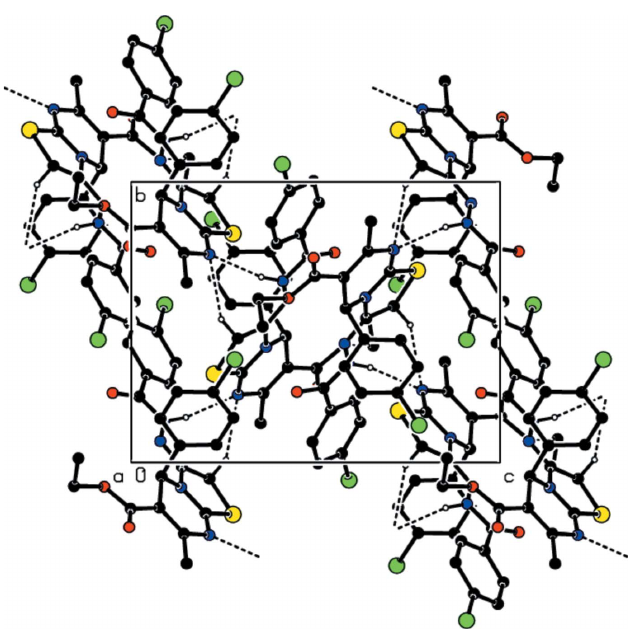
Figure 4 Packing viewed along the a -axis direction with intermolecular inter- actions shown as in Fig. 2.